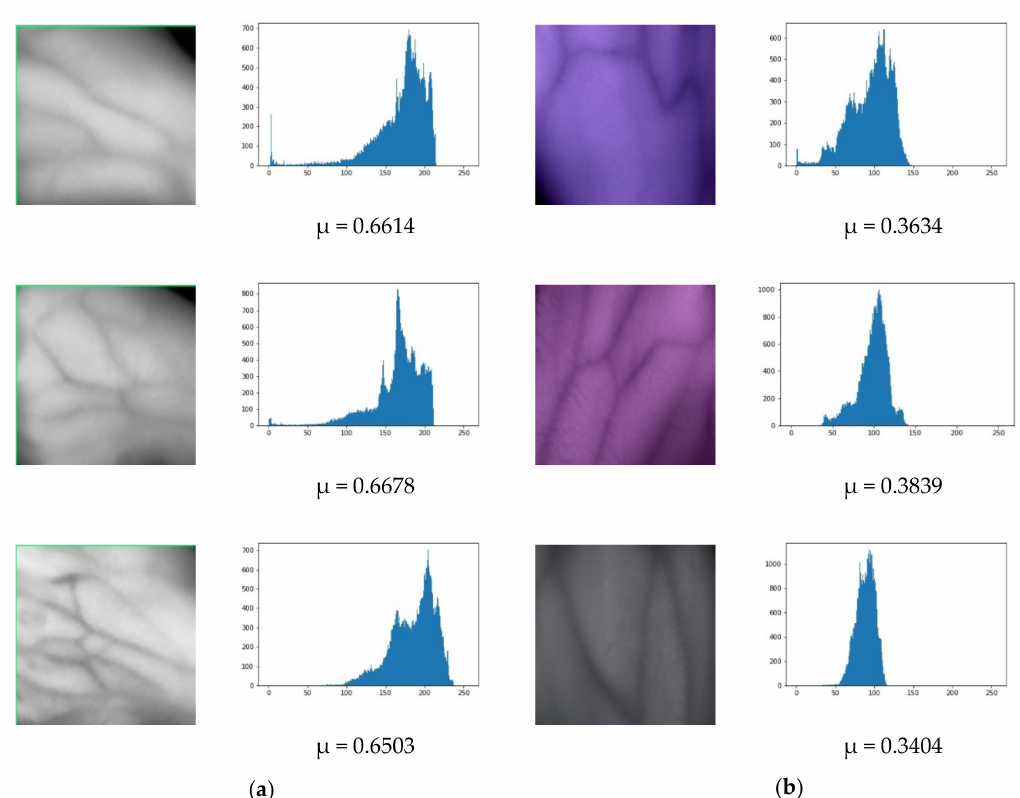
Figure 5. Original hand vein images with their corresponding histograms and mean intensities: ( a ) self-acquisition database, ( b ) SUAS database.